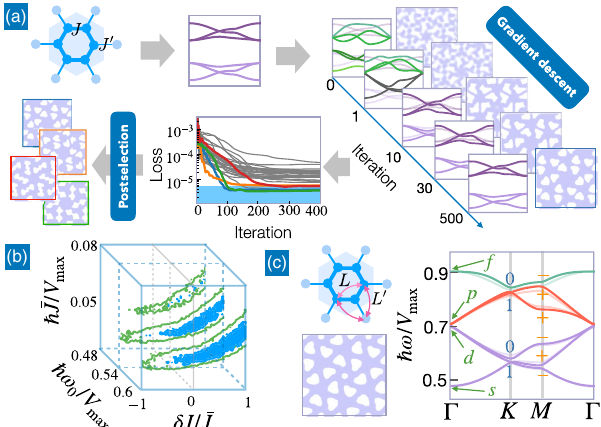
FIG. 6. Using the NN for gradient-based optimization. (a) Pipe- line for finding a physical implementation of a given TB model (unit cell shown). The band structure of the model is provided as a target. A randomly initialized geometry is evolved until the NN- predicted band structure (dark lines) approaches the target (bright lines); see also the animation in the Supplemental Video [60]. We select those random trials that end up at a loss comparable to the NN accuracy itself (blue shaded region). (b) Physically accessible regions of the TB model parameter space: Contours show the minimal loss achieved after 50 trials as a function the parameters ¯ J (on-site energy ω 0 , average hopping ¼ ð J þ J 0 Þ = 2 , hopping difference δ J ¼ J 0 − J ). In the blue region, the minimal loss is lower than the network accuracy. (c) Solutions for a more general model, including also next-nearest-neighbor hopping supporting fragile topological phases; see Appendix M for more details. The parameters are ℏ ω 0 ¼ 0 . 6 V , ℏ J 0 ¼ 0 . 038 V , max max